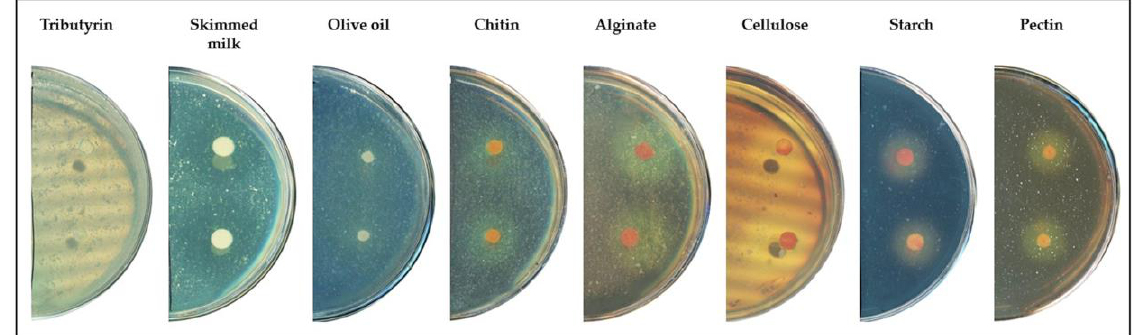
Figure 2. Lytic enzymatic activities observed for Saccharopolyspora sp. NFXS83 when cultivated in marine basal medium supplemented with different substrates. Enzymatic activities measured by the degradation halo diameter.